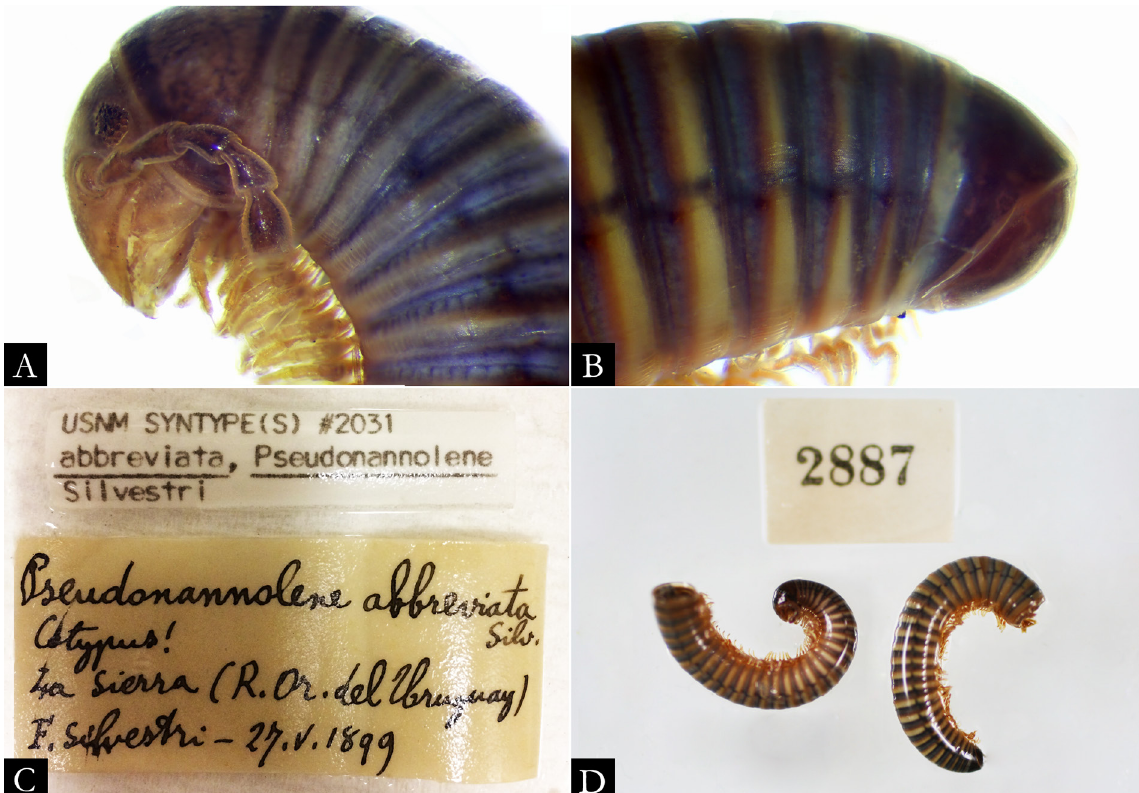
Fig. 139. Type material of the junior subjective synonym Pseudonannolene abbreviata Silvestri, 1902 (= P. typica Silvestri, 1895). A . Anterior region. B . Posterior region. C . Original label of female syntype (USNM 2031). D . Original label of female syntype (ZMB 2887). Images not to scale.